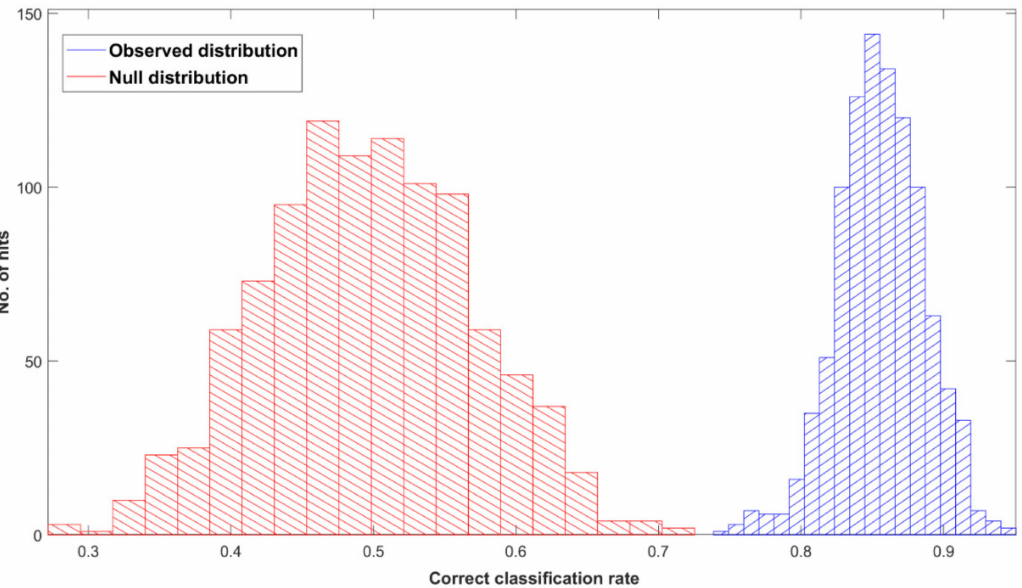
Figure 3. Permutation tests’ output plot; null (red) and observed (blue) distribution classification rated for Cohort A with a partial least squares discriminant analysis (PLS-DA) classification model after 1000 bootstraps, using pre-processed